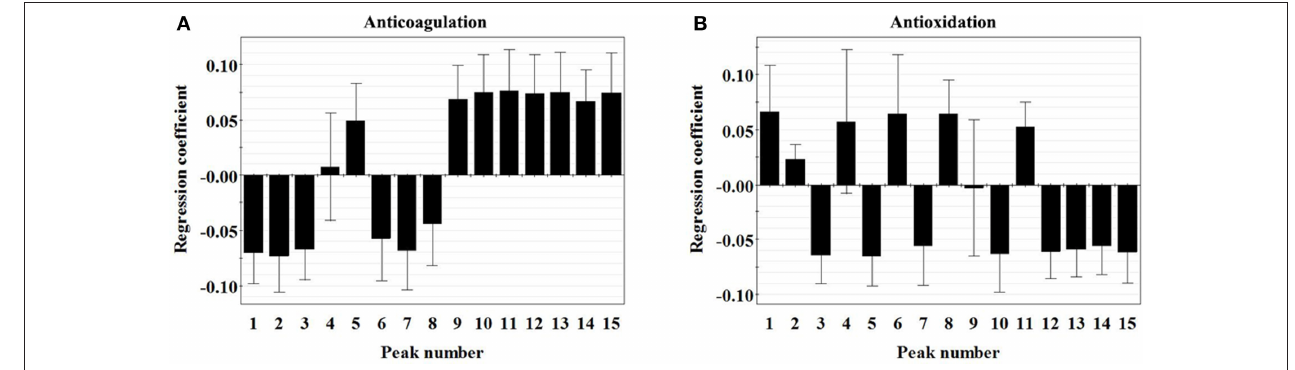
FIGURE 4 | Regression coefficient plots of the anticoagulation (A) and antioxidation (B) of 15 peaks in the chromatograms of Panax notoginseng roots.